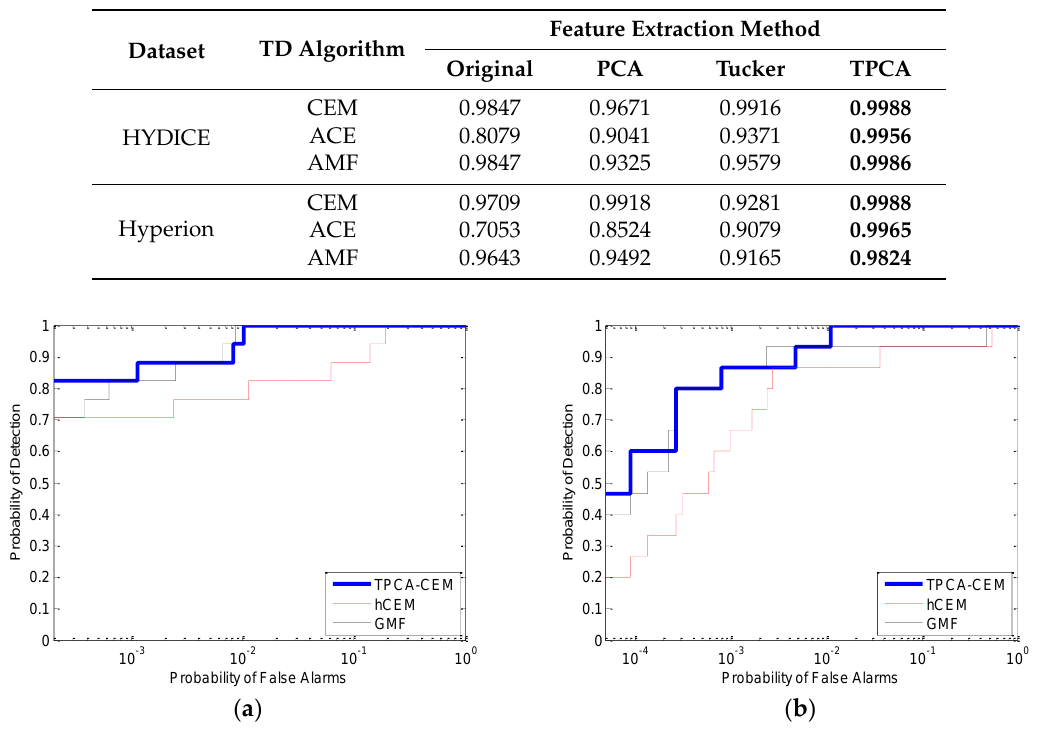
Table 6. AUCs and running time for the TD of synthetic datasets with different TD algorithms.